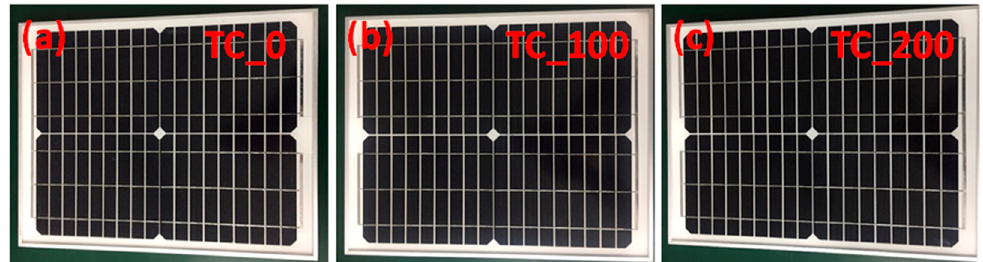
Figure 2. Optical images of reference PV module after thermal cycles of ( a ) 0, ( b ) 100, and ( c ) 200 cycles).